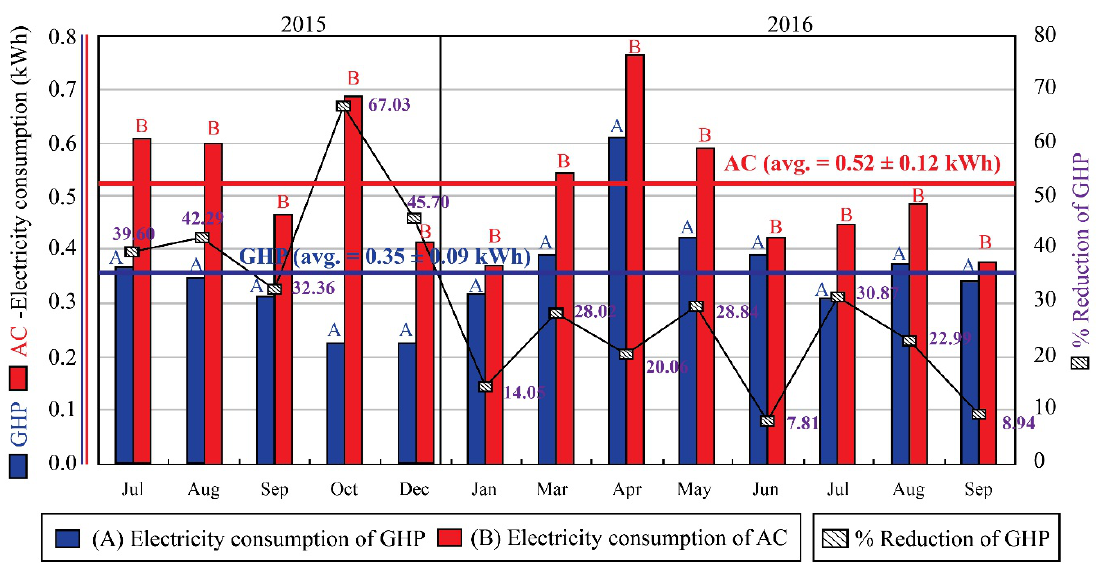
Figure 8. The comparison of electricity consumption of GHP- and normal air-conditioners (AC) when operating at 25 °C in a long-term measurement (July 2015 to September 2016) at the experimental room, Parot Racha Building, Chulalongkorn University.